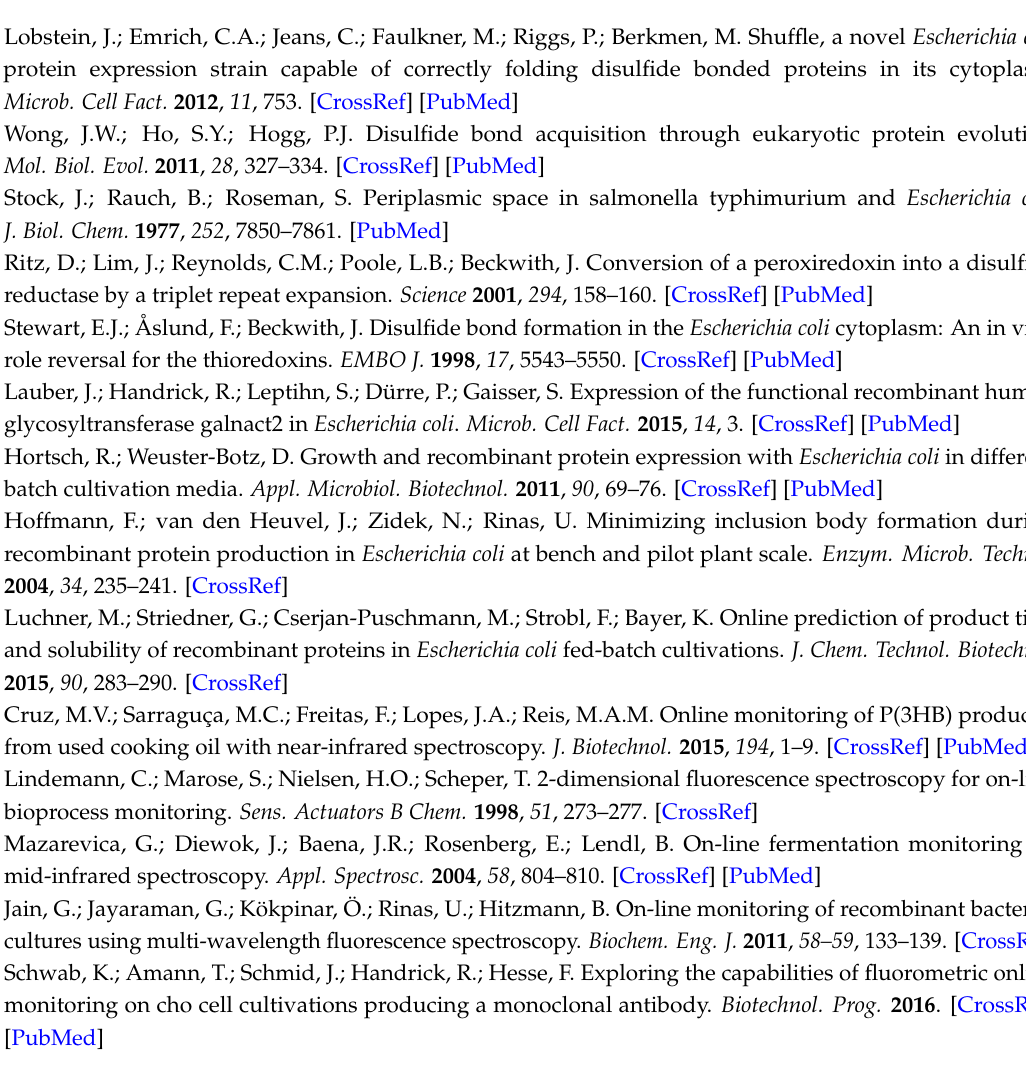
Figure S1: E. coli Shuffle ® T7 cell factory LB-medium fed-batch process. OD 600 , as well as glucose and acetate, concentrations were measured offline. The glucose target concentration for the feed was 1 g · L − 1 . The cell factory was induced following the same protocol as described for the EnPresso ® B medium. Only negligible amounts of glycosyltransferase were formed and the fermentation was stopped after increased inclusion body accumulation was observed and the E. coli cell morphology